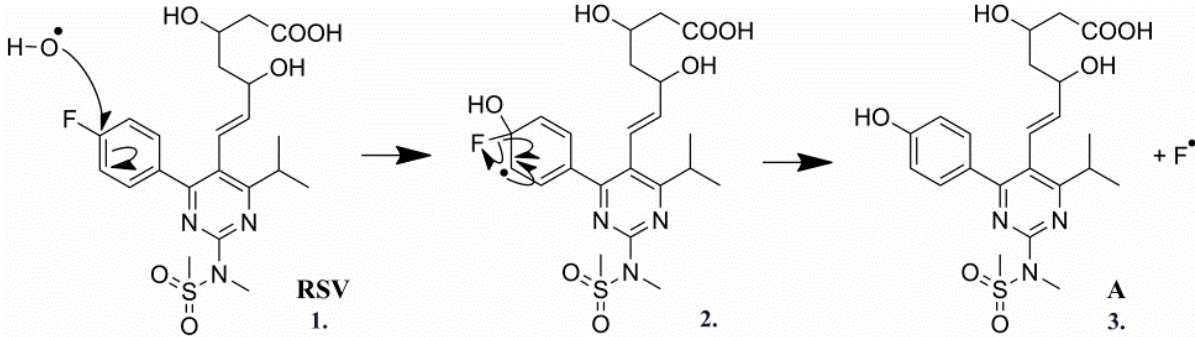
Figure 4. Fragmentation MS/MS spectra of product A [M + H] + ion (precursor ion mass m/z 480.1806) obtained by using collision energy of 25 V.